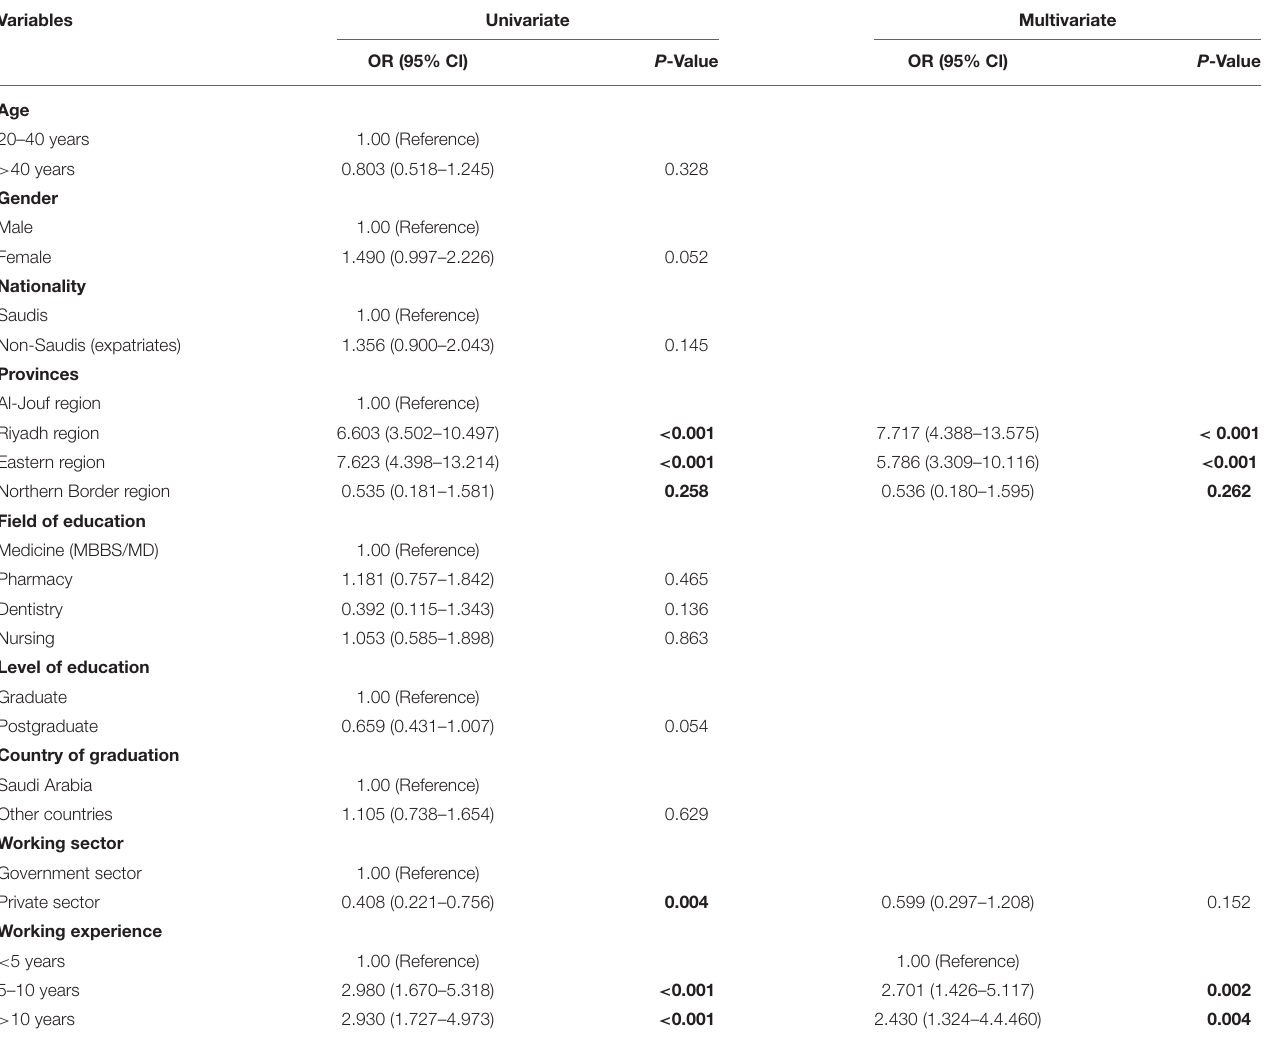
TABLE 6 | Predictors of achieving ≥ 50% knowledge